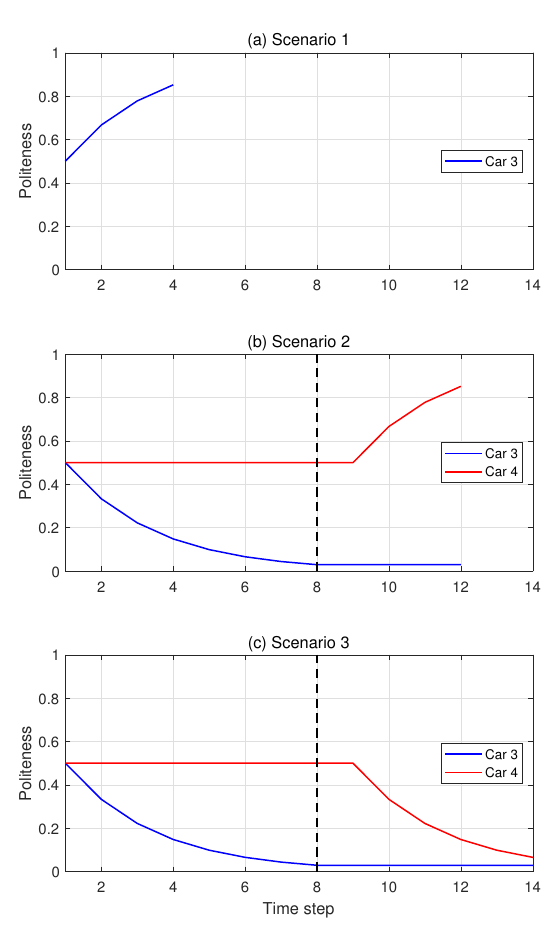
Figure 8. Estimated politeness of target vehicles for each